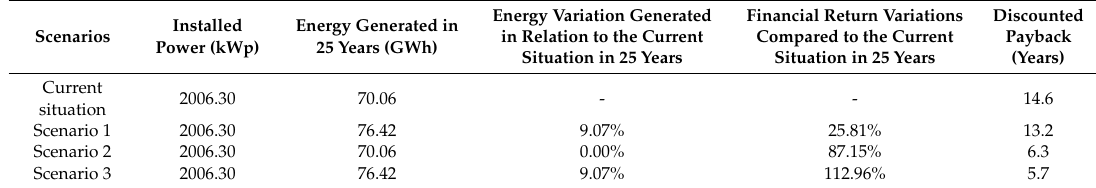
Table 7. Overview of the entire IFRN photovoltaic system considering the current situation and Scenarios 1, 2, and